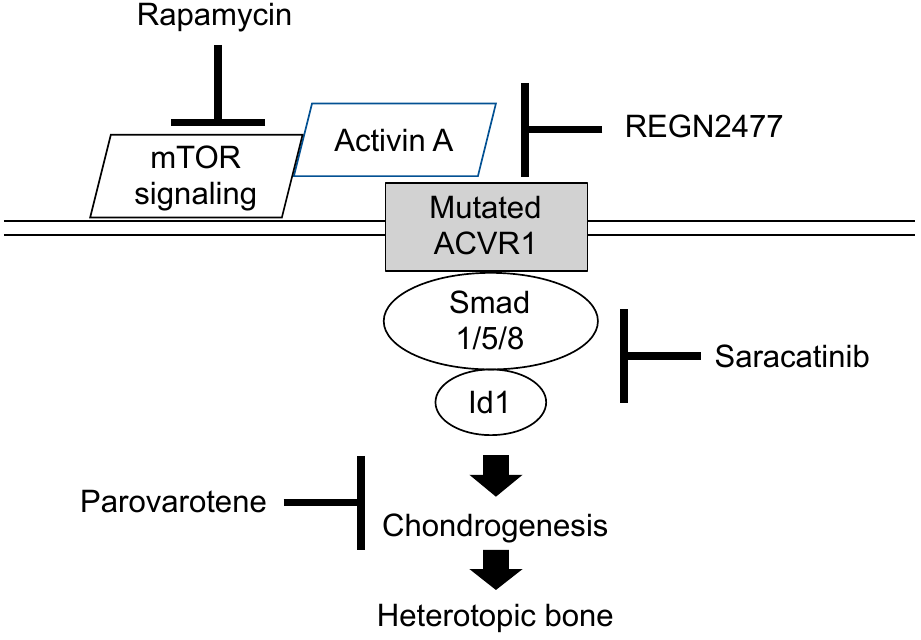
Figure 9. Molecular targeting of therapeutic drugs on on-going phase 2 or 3 clinical trials.